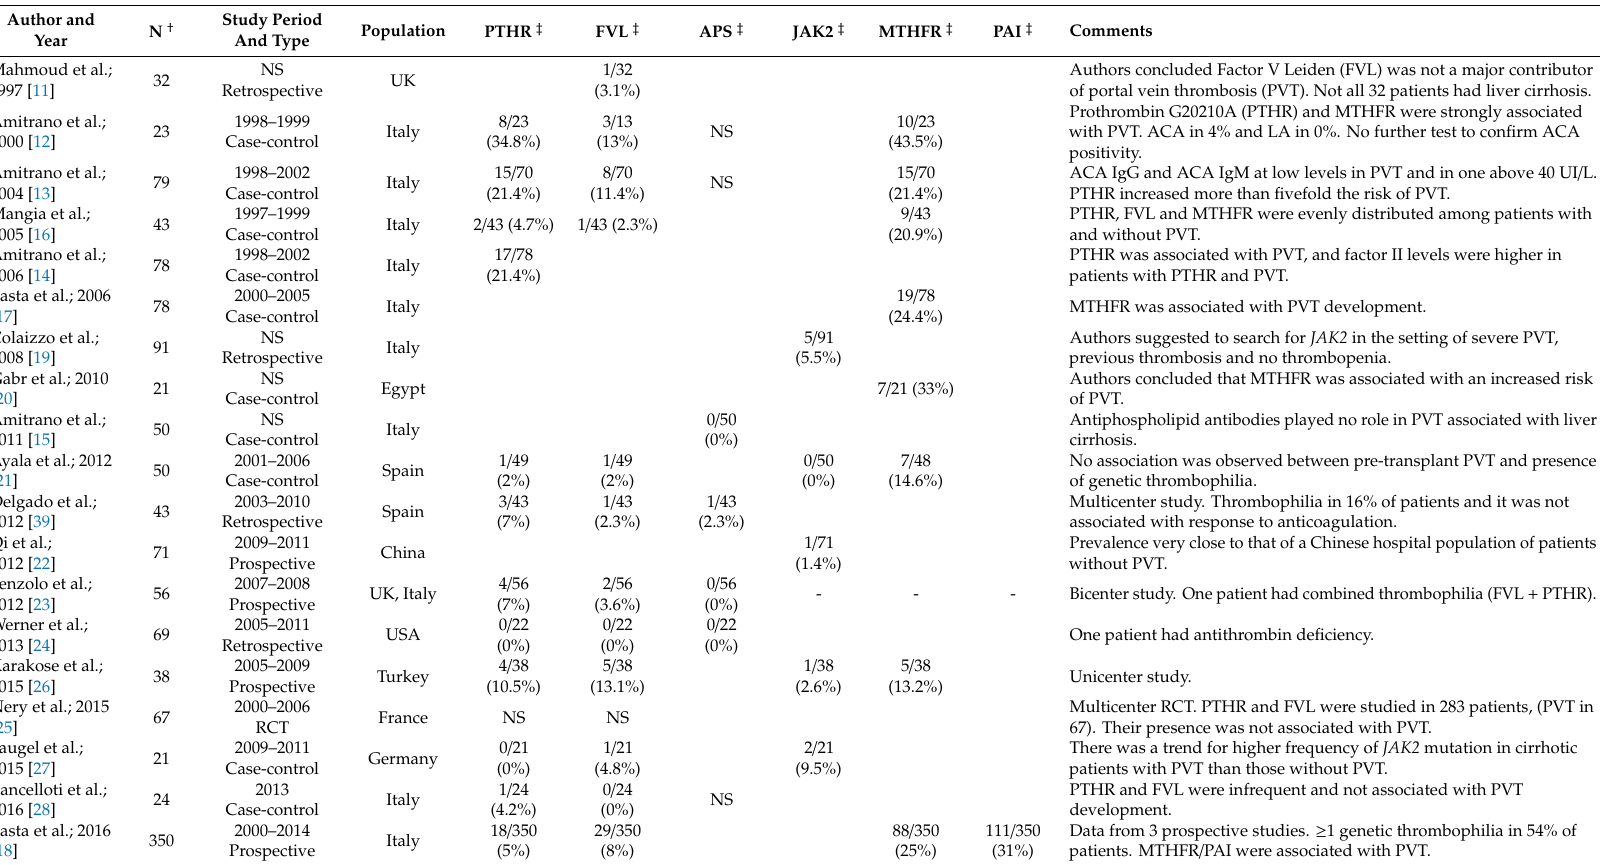
Table 5. Large studies evaluating the prevalence of acquired and inherited thrombophilia in non-malignant portal vein thrombosis in patients with liver cirrhosis